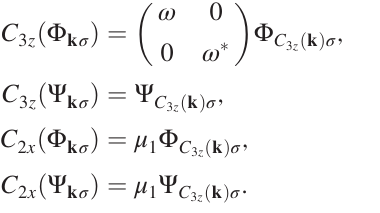
FIG. 15. Phonon dispersion obtained with our choice of intra- layer and interlayer potentials in Bernal-stacked bilayer